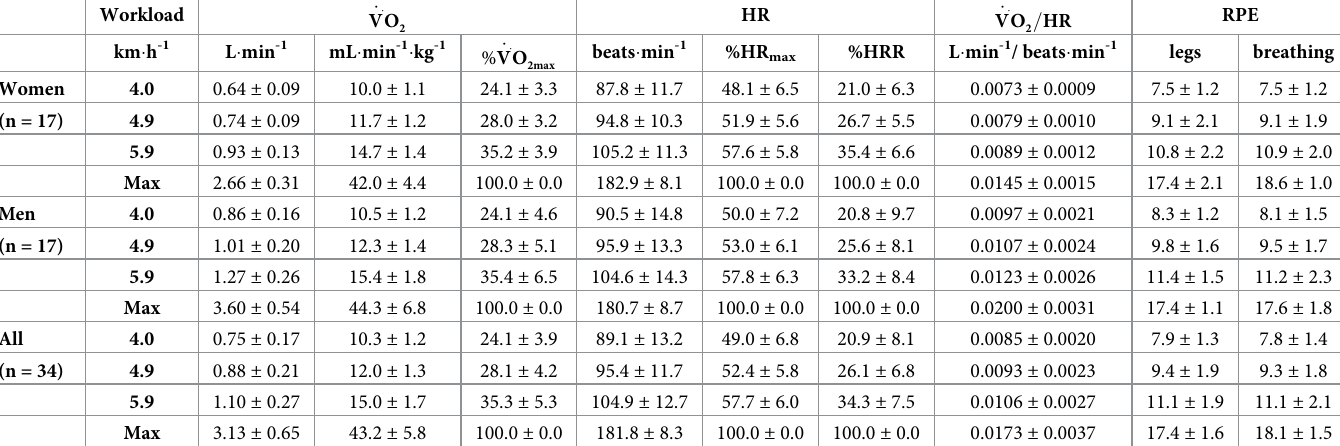
Table 3. _ V _ O , HR, _ V _ O = HR and RPE during submaximal (walking) and maximal (running) treadmill exercise (means ± SD). 2 2 Workload